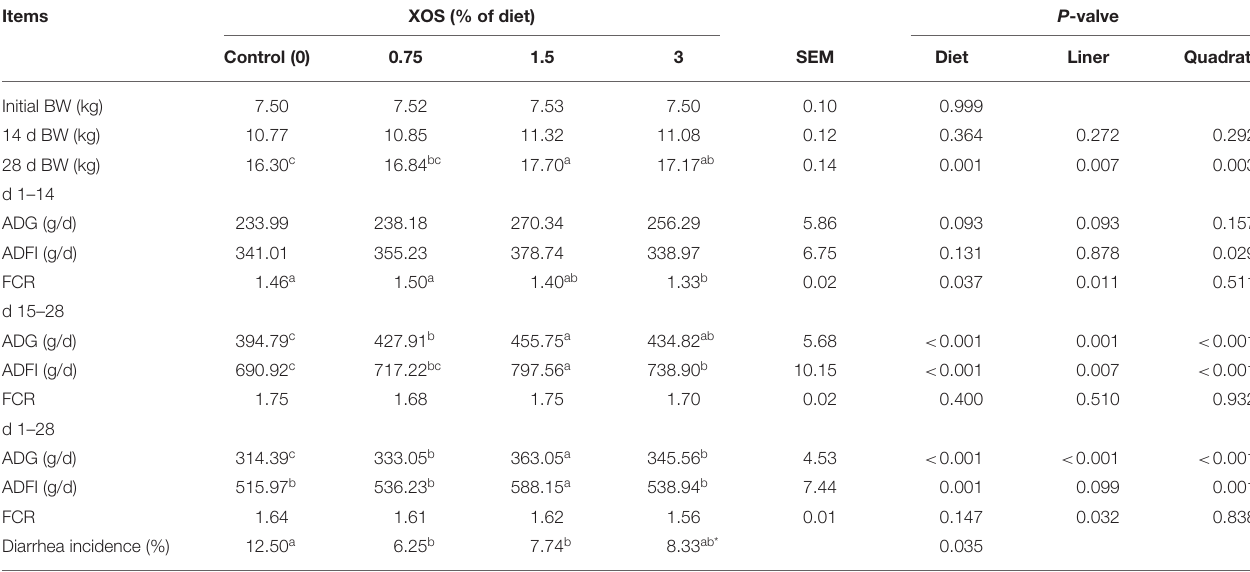
TABLE 3 | The effects of XOS supplementation on growth performance of weaning piglets. Items